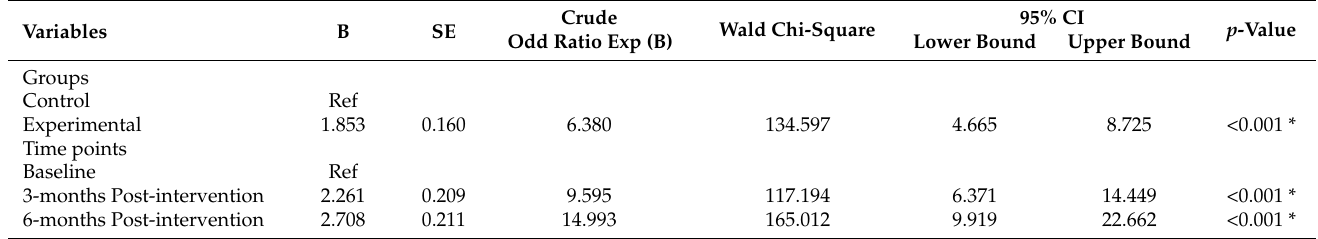
Table 4. Comparison of Knowledge of Malnutrition between Groups and Time Points using